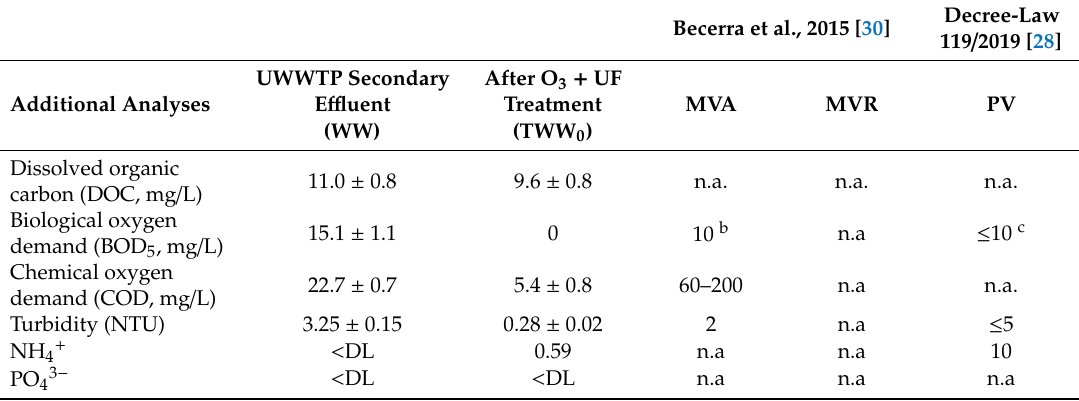
Table 2. Additional analyses made to the UWWTP secondary e ffl uent, before (WW) and immediately after treatment (TWW 0